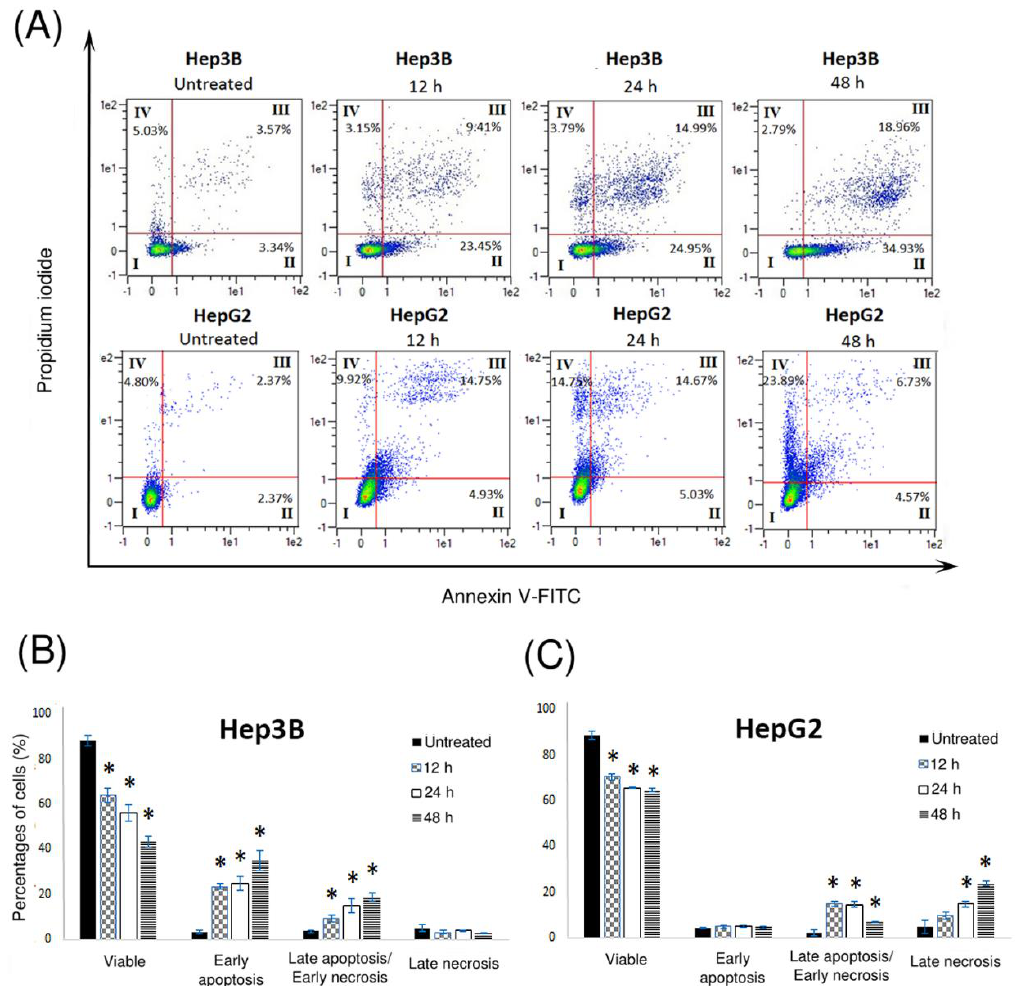
Figure 4. Pinnatane A induced apoptosis in Hep3B and necrosis in HepG2 cells. ( A ) Detection of